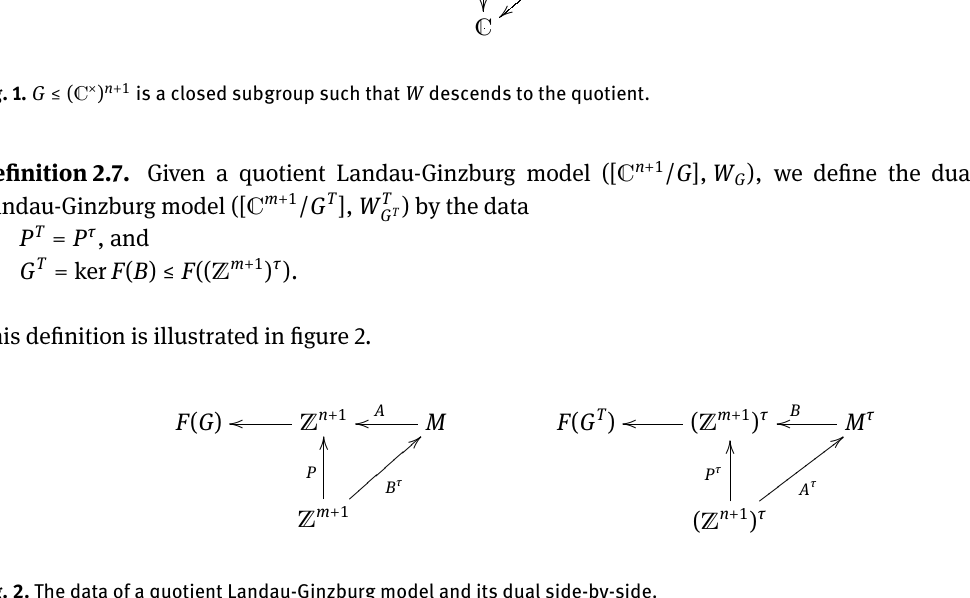
Fig. 2. The data of a quotient Landau-Ginzburg model and its dual